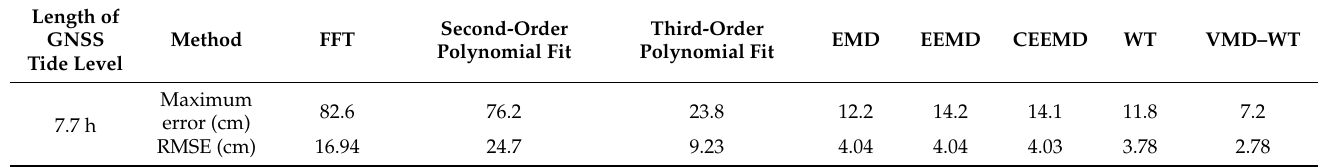
Table 1. Comparison of filtering effects of the eight methods for 7.7